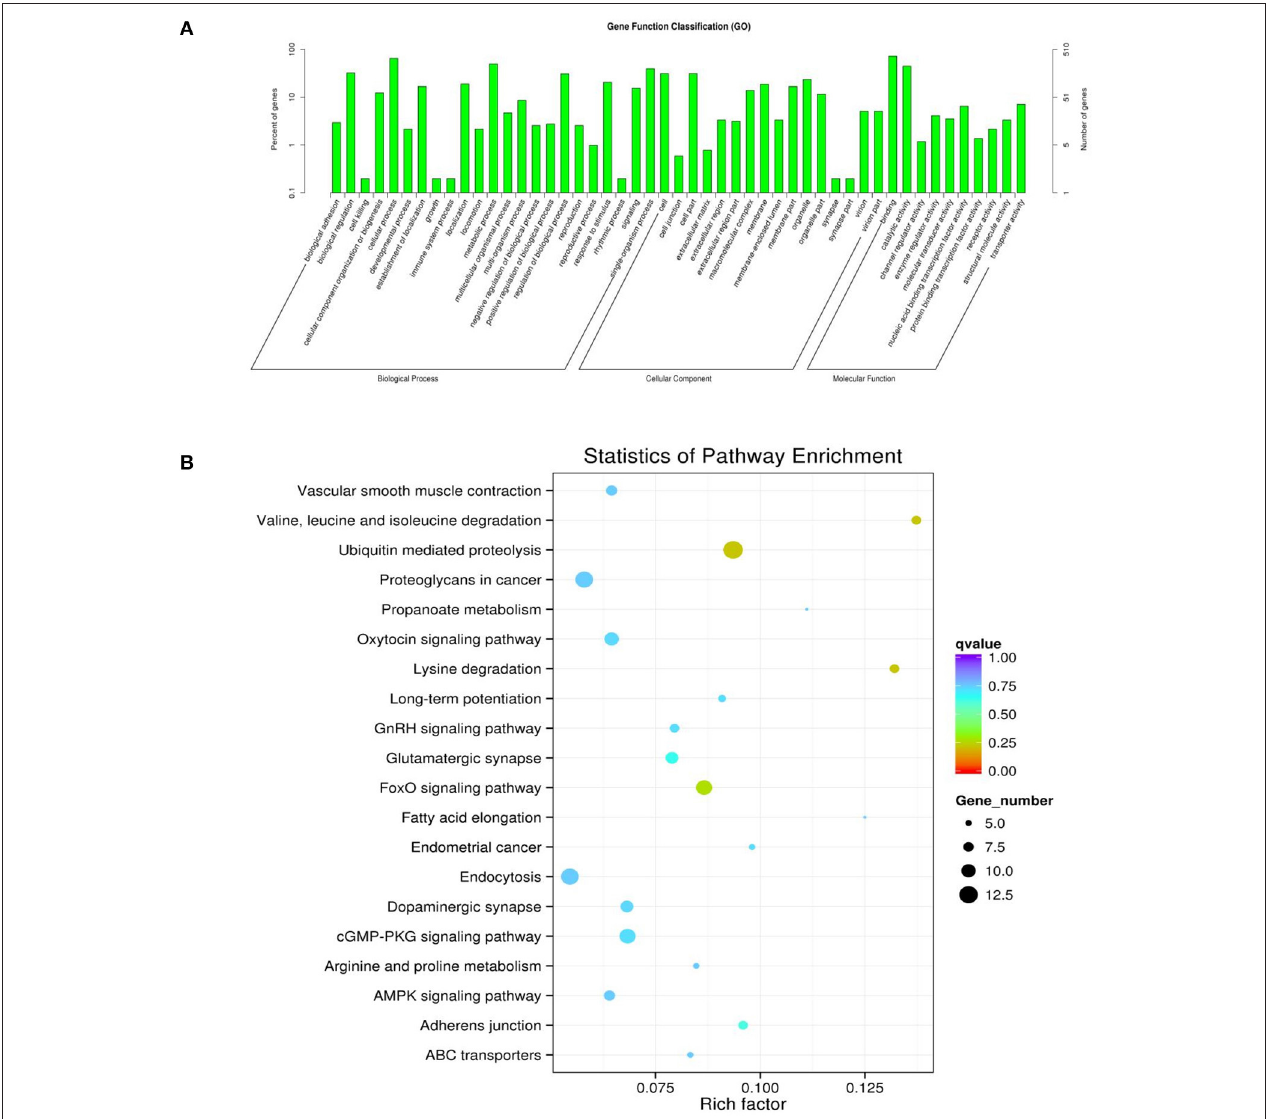
FIGURE 5 | GO and KEGG diagrams. (A) Forty-nine different GO term annotations of the parental genes of differentially expressed circRNAs. The abscissa is the ontology classification, and the ordinate is the proportion of genes annotated to this term among all the annotated genes. (B) The parental genes of the differential circRNAs for the 20 pathways that are significantly enriched; the closer the color is to red, the higher the enrichment degree. The size of each dot indicates the number of genes enriched in the KEGG entry. The larger the dot is, the more genes enriched in the KEGG entry, and vice